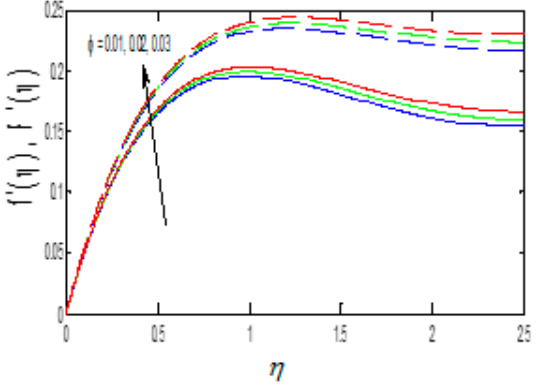
Figure 3. Impact of φ on velocity profile ' f and ' F of fluid with dusty particles.